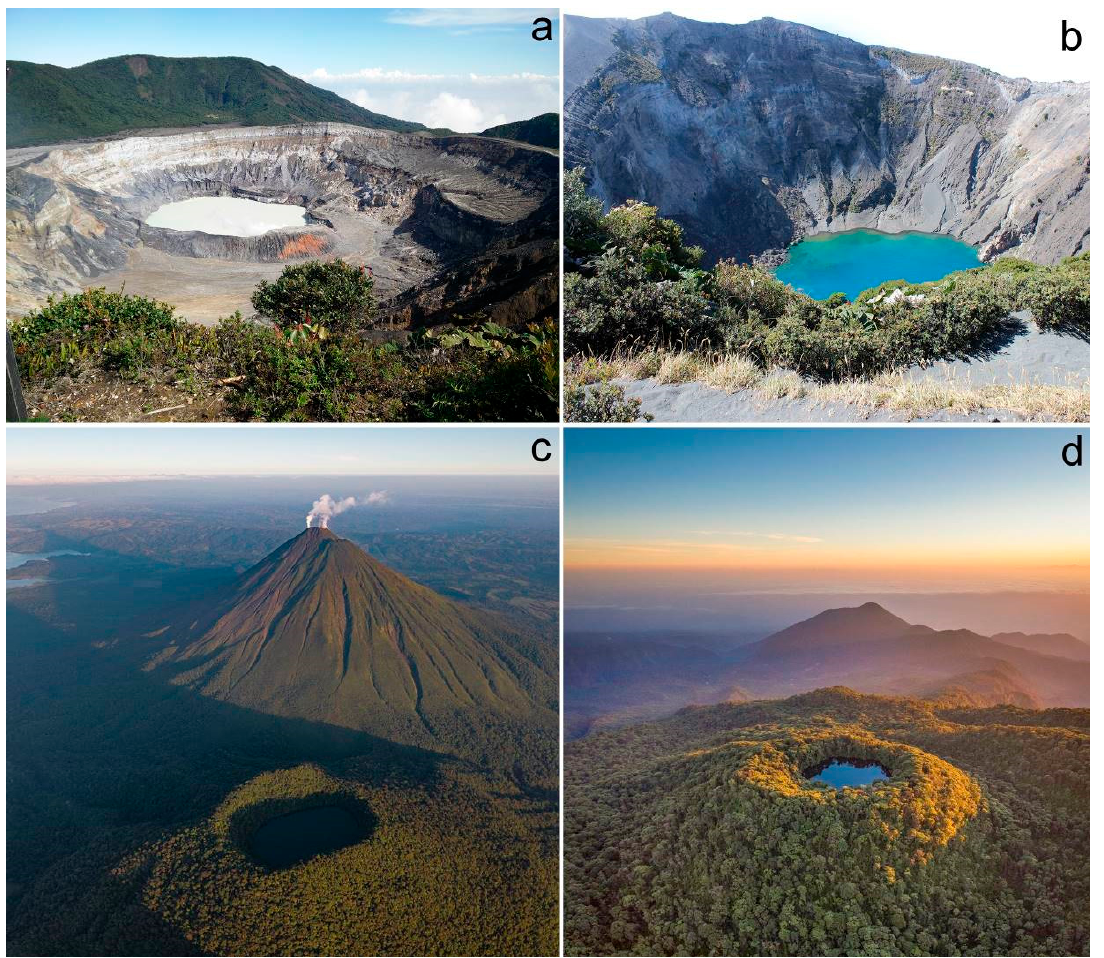
Figure 5. ( a ). Volcanic landforms: Poás volcano National Park; ( b ). Irazú National Park; ( c ). Arenal National Park (photo courtesy of Leonel León); ( d ). Braulio Carrillo National Park and Barva volcano (photo courtesy of Leonel León).